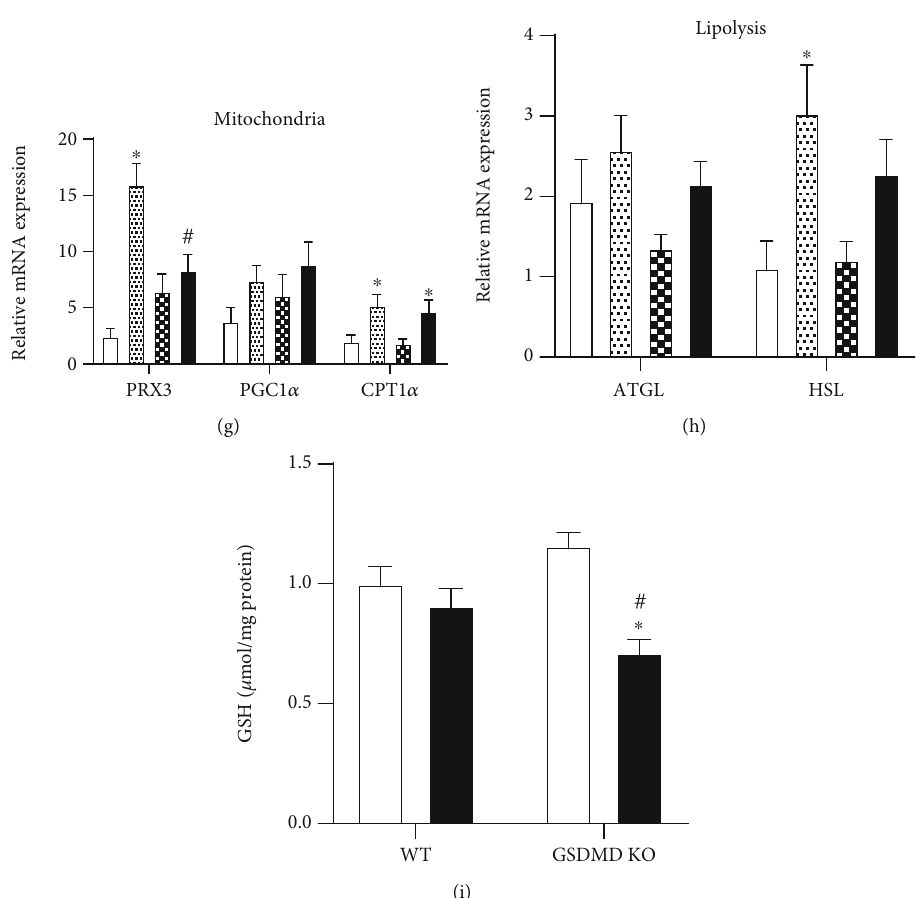
Figure 3: Liver in fl ammation and metabolism in wild-type (WT) and gasdermin D knockout (GSDMD KO) mice fed a high-fat diet (HFD). (a) Representative western blots and quantitative analysis of GSDMD in liver. (b) IL-1 β protein expression in liver was measured by ELISA assay. (c) Representative western blots and quantitative analysis of pro-caspase1 and caspase1 in liver. The expression level of protein was normalized using β -tubulin. (d – h) Real-time PCR analysis of genes in the liver. The expression level of each target was normalized using 18S rRNA. (i) GSH concentration in liver was evaluated by GSH Detection Assay kit. ∗ p < 0 : 05 vs. same genotype mice fed a NCD, † p < 0 : 05 vs. WT NCD group, and # p < 0 : 05 vs. WT HFD